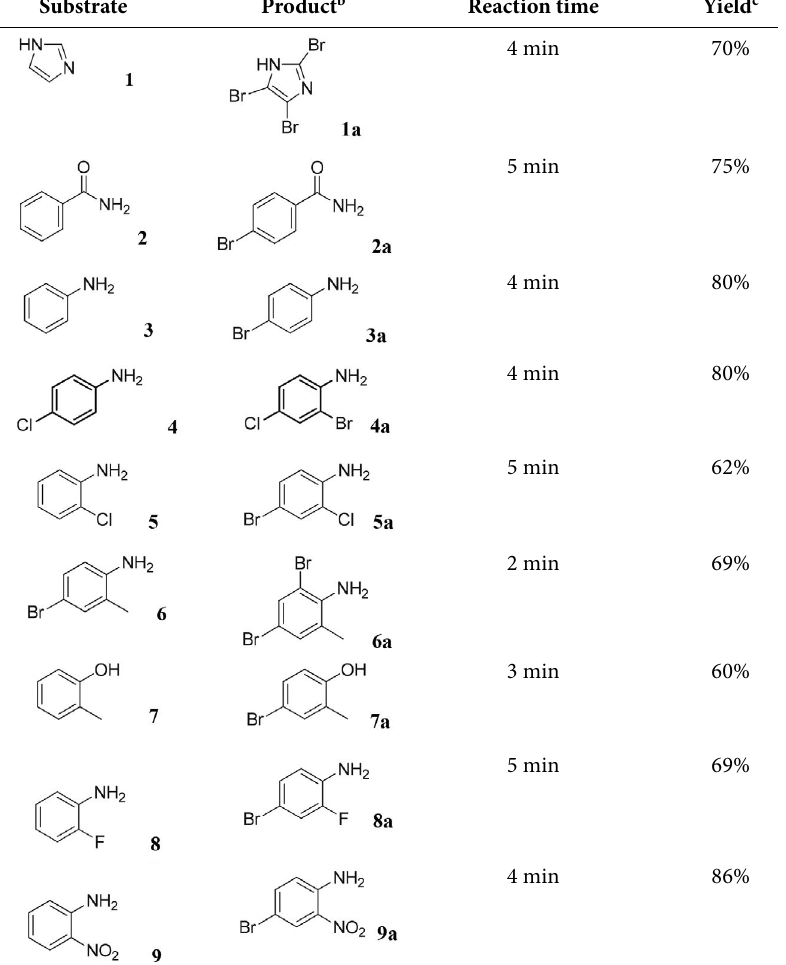
Table 1. Aqueous microwave bromination of organic substrates with CTMATB a